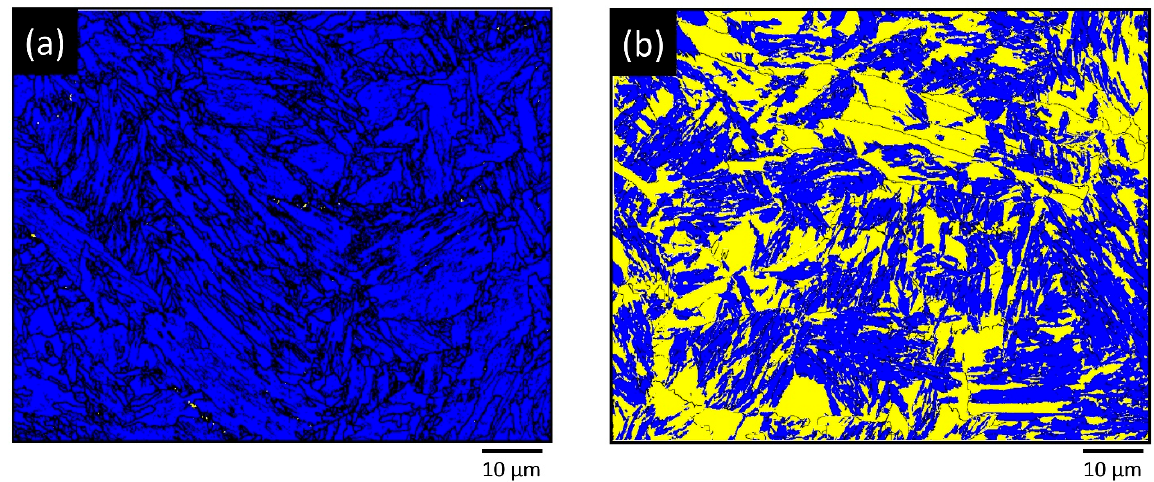
Figure 6. EBSD data on the same 17-4specimen with two different surface finishes. ( a ). Mechanical polish to 1 µm, followed by a 16 h vibratory polishing step using colloidal SiC. ( b ) The same polish steps as ( a ), followed by two ion mill steps. The first step was 30 min at 400 V, 7 mA and the second step was 40 min at 200 V, 2 mA. In both ( a ) and ( b ), blue region indicates martensite and yellow region indicates austenite.